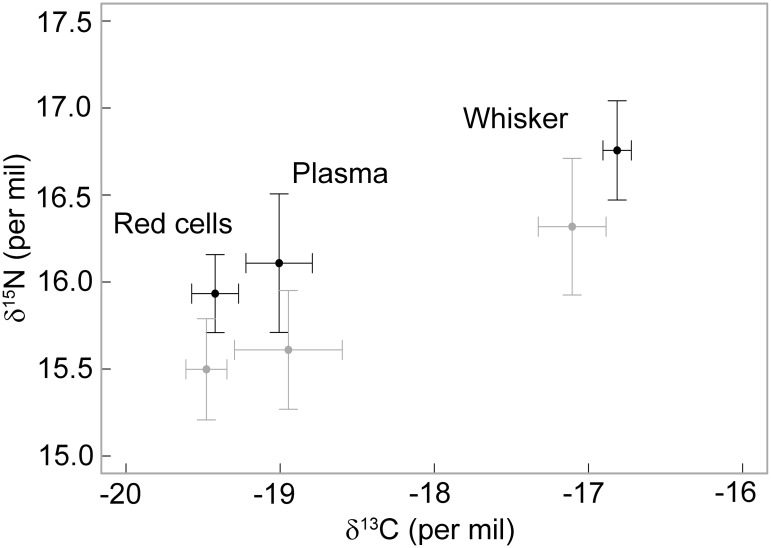
Plasma, red blood cells and mean whisker δ13C and δ15N values of male (black) and female (grey) Australian fur seals sampled in winter.Values are mean ± standard deviation.